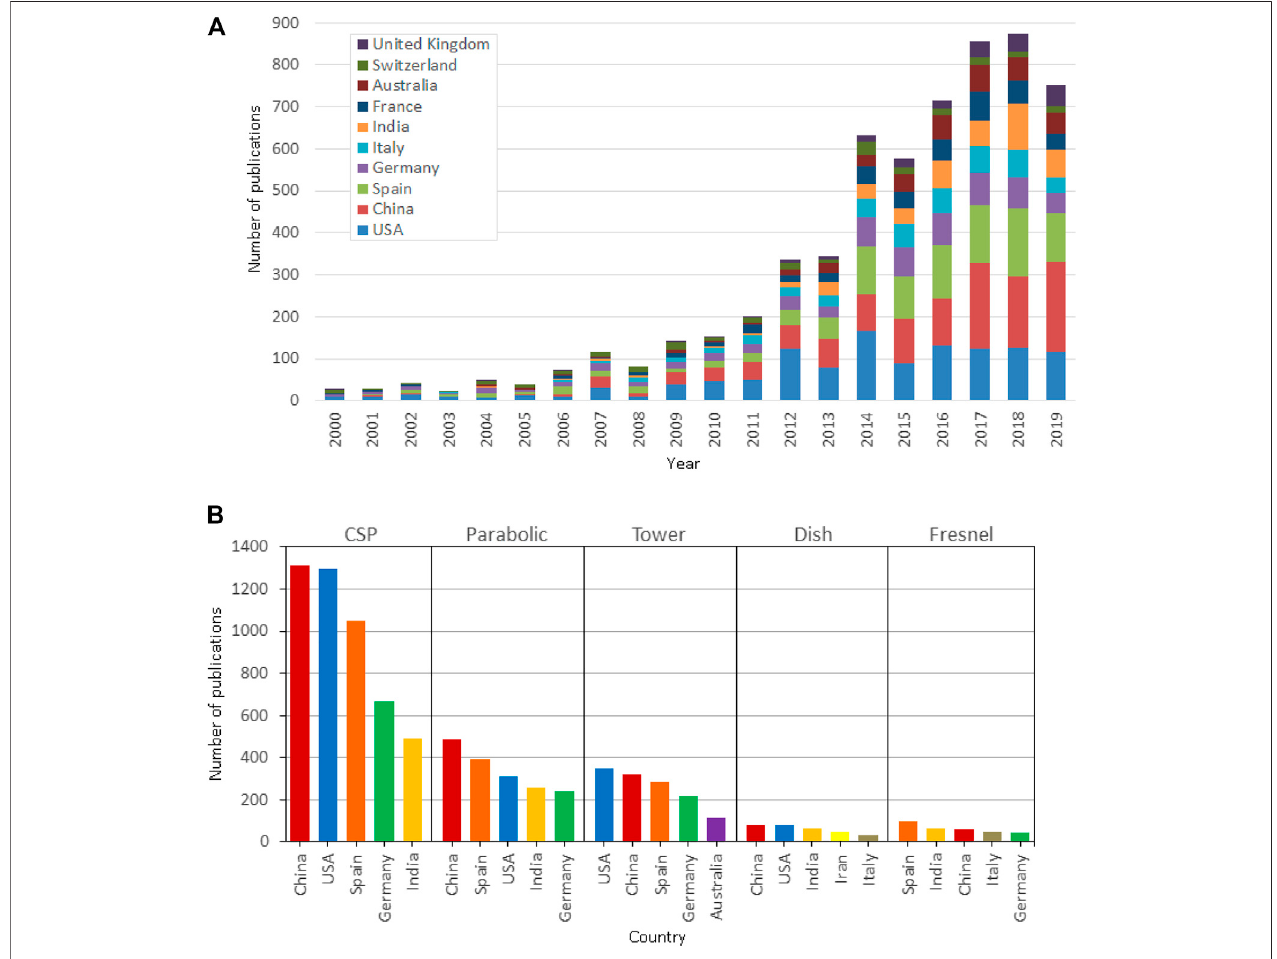
FIGURE4 | (A) Publication evolution regardingthe CSP fi eld inthe last 2 decades by countries; (B) Total publications in CSP fi eldand its sub research fi elds of the top fi ve countries.